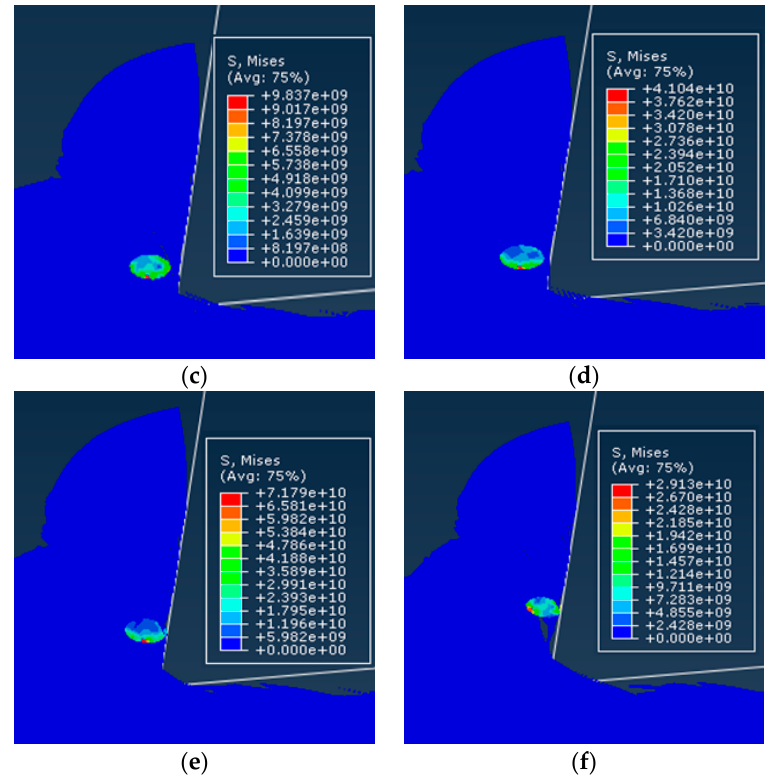
Figure 18. Simulation of the cutting process while the particles are positioned above the cutting path: ( a ) Stress concentration in the particle, ( b ) rising of particle along the rake face, ( c ) maximum forces under the particle, ( d ) particle begin to peel off from the matrix, ( e ) part of the matrix adheres to the particle, and ( f ) particle gradually break away from the chips.